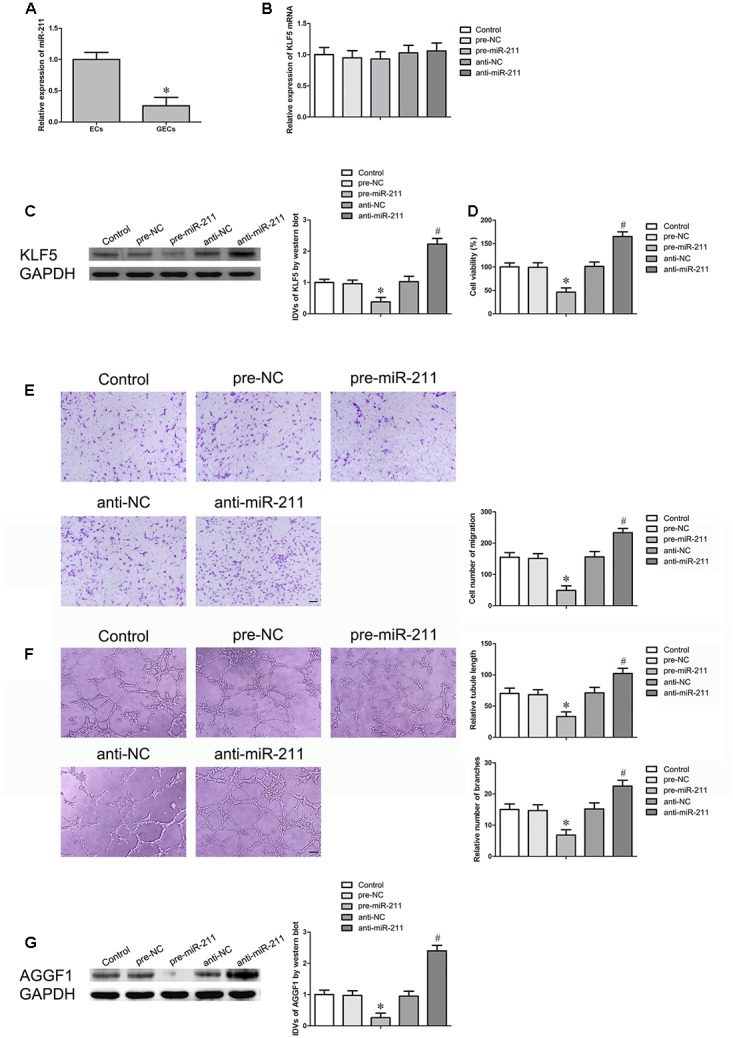
miR-211 expression in GECs and regulation of miR-211 on GBM angiogenesis, KLF5 and AGGF1 expression. (A) Relative miR-211 expression in ECs and GECs by quantitative real-time PCR. Data are presented as mean ± SD. (n = 5, each group), ∗P < 0.01 vs. ECs group. (B,C) Effect of miR-211 on the expression of KLF5 mRNA and KLF5 protein level. (D) CCK-8 assay was used to evaluate the effect of miR-211 on GECs proliferation. (E) Effect of miR-211 on quantification number of GECs migration. (F) Effect of miR-211 on GECs tube formation. Data are presented as mean ± SD. (n = 5, each group), ∗P < 0.05 vs. pre-NC group; #P < 0.05 vs. anti-NC group. (G) The effect of miR-211 on expression of AGGF1 by Western blot assay. Data are presented as mean ± SD. (n = 5, each group), ∗P < 0.01 vs. pre-NC group; #P < 0.01 vs. anti-NC group. Scale bars represent 30 μm.